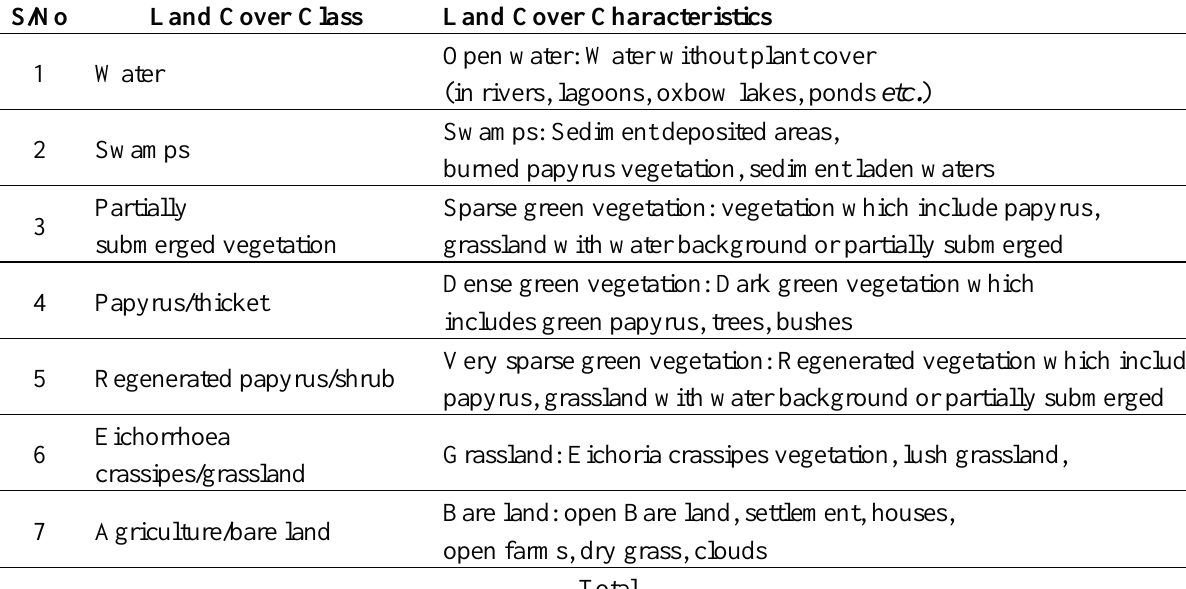
Table 1. Field vegetation classification in